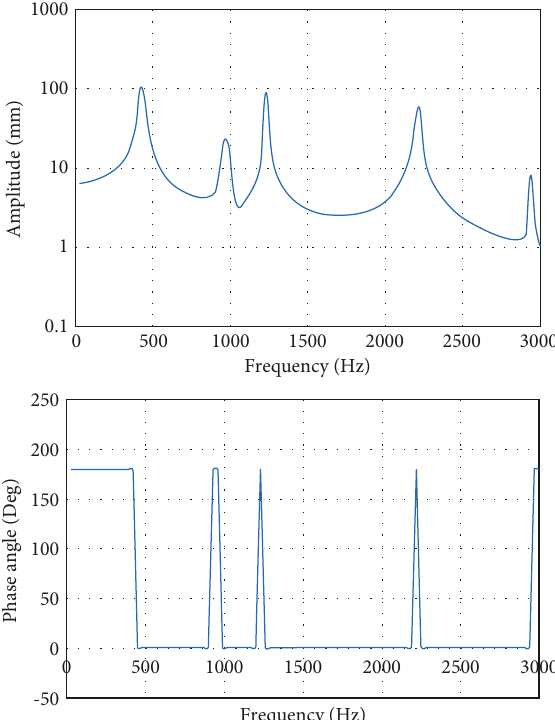
Figure 22: Frequency response of FGM crankshaft at the fifth mode of